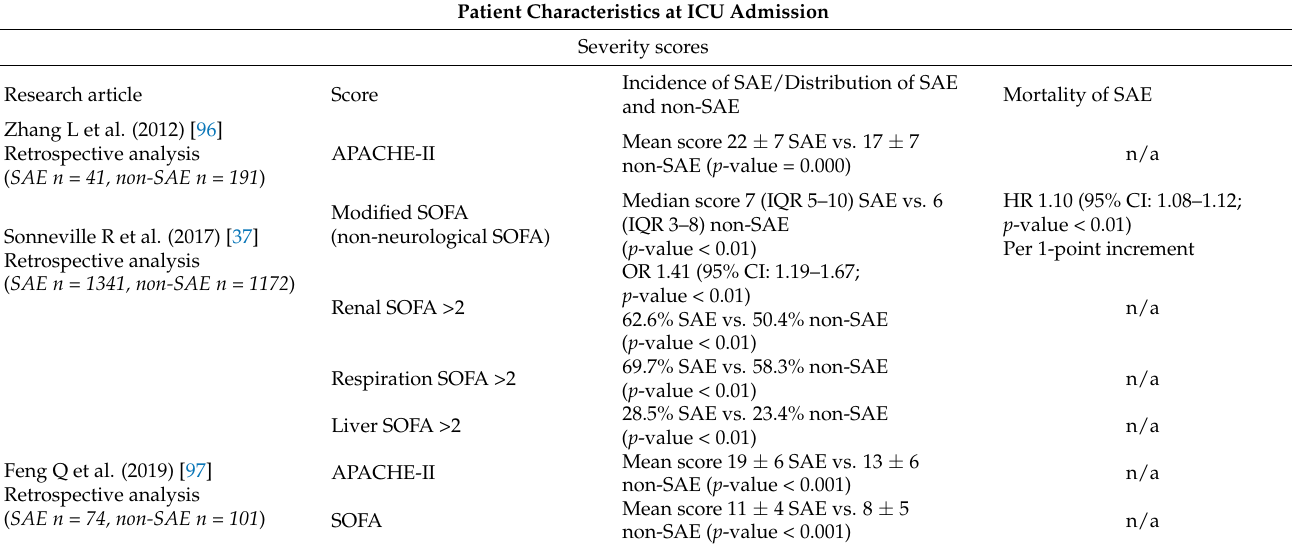
Table 3. Patient characteristics at ICU admission and incidence of